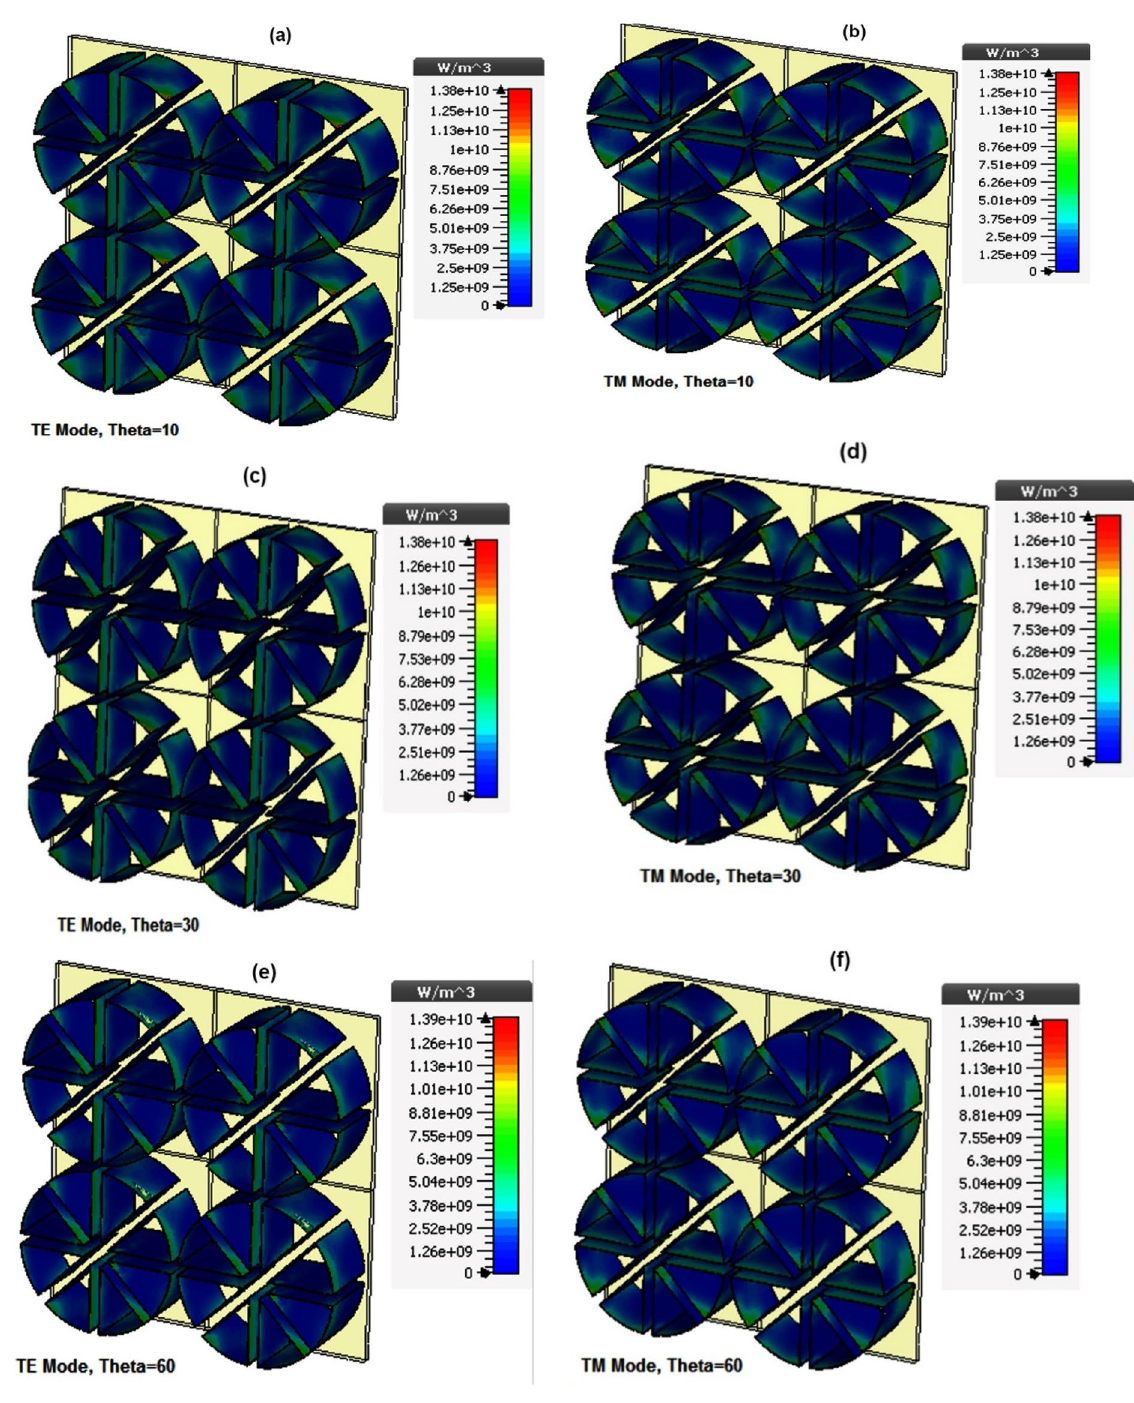
Figure 10. Power loss density based on oblique incidence at the central frequency (220 GHz) for ( a ) Theta = 10, TE Mode ( b ) Theta = 10, TM Mode ( c ) Theta = 30, TE Mode ( d ) Theta = 30, TM Mode ( e ) Theta = 60, TE Mode ( f ) Theta = 60, TM